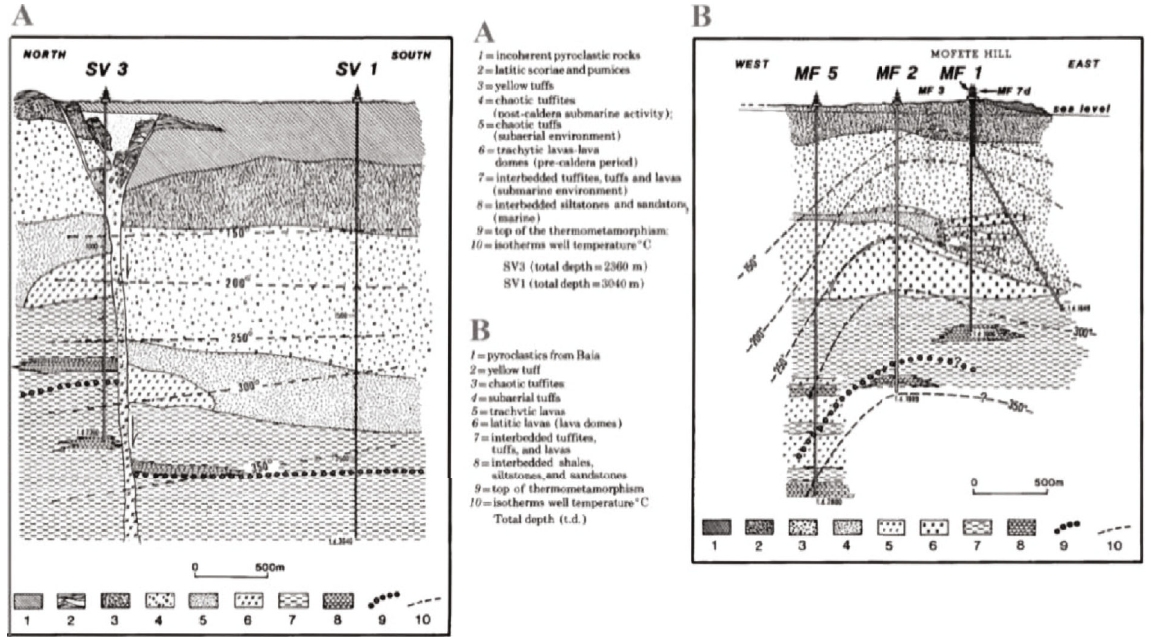
Figure 5: (a) Cross-section including SV1 and SV3 wells. (b) Cross-section including MF1, MF2, and MF5 vertical wells. MF3 and MF7d wells are also shown. See Figure 1 for location (from Agip [70]; De Vivo et al.